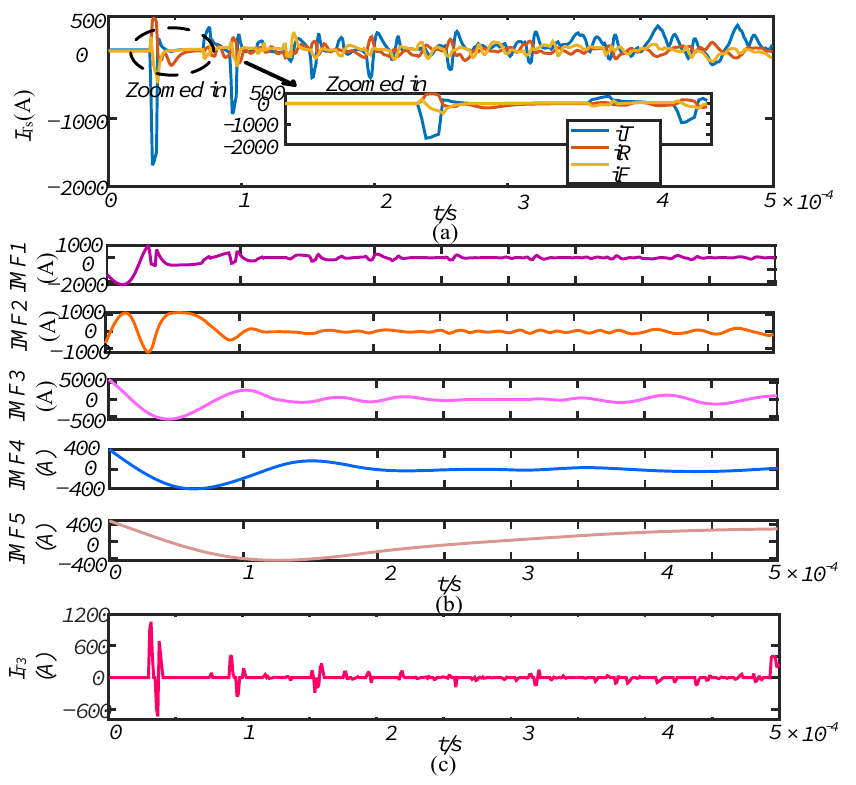
Figure 12. Analysis diagram of shielding flashover waveform and HHT signal.